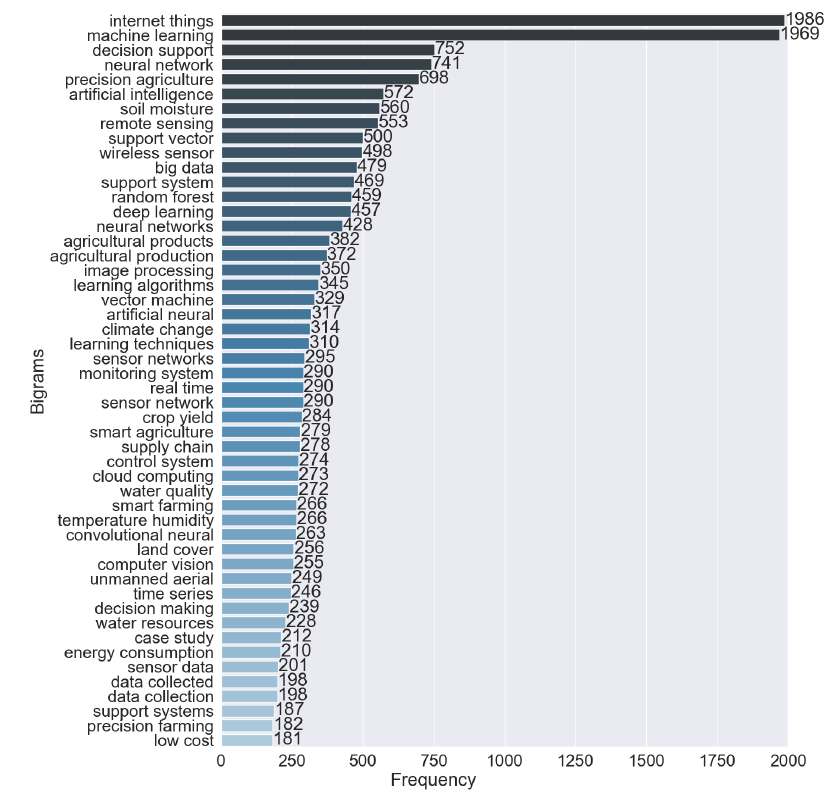
Figure 2. Top 50 of most frequent bigrams resulting from the analysis of the corpus of 8485 abstracts, using the NLP